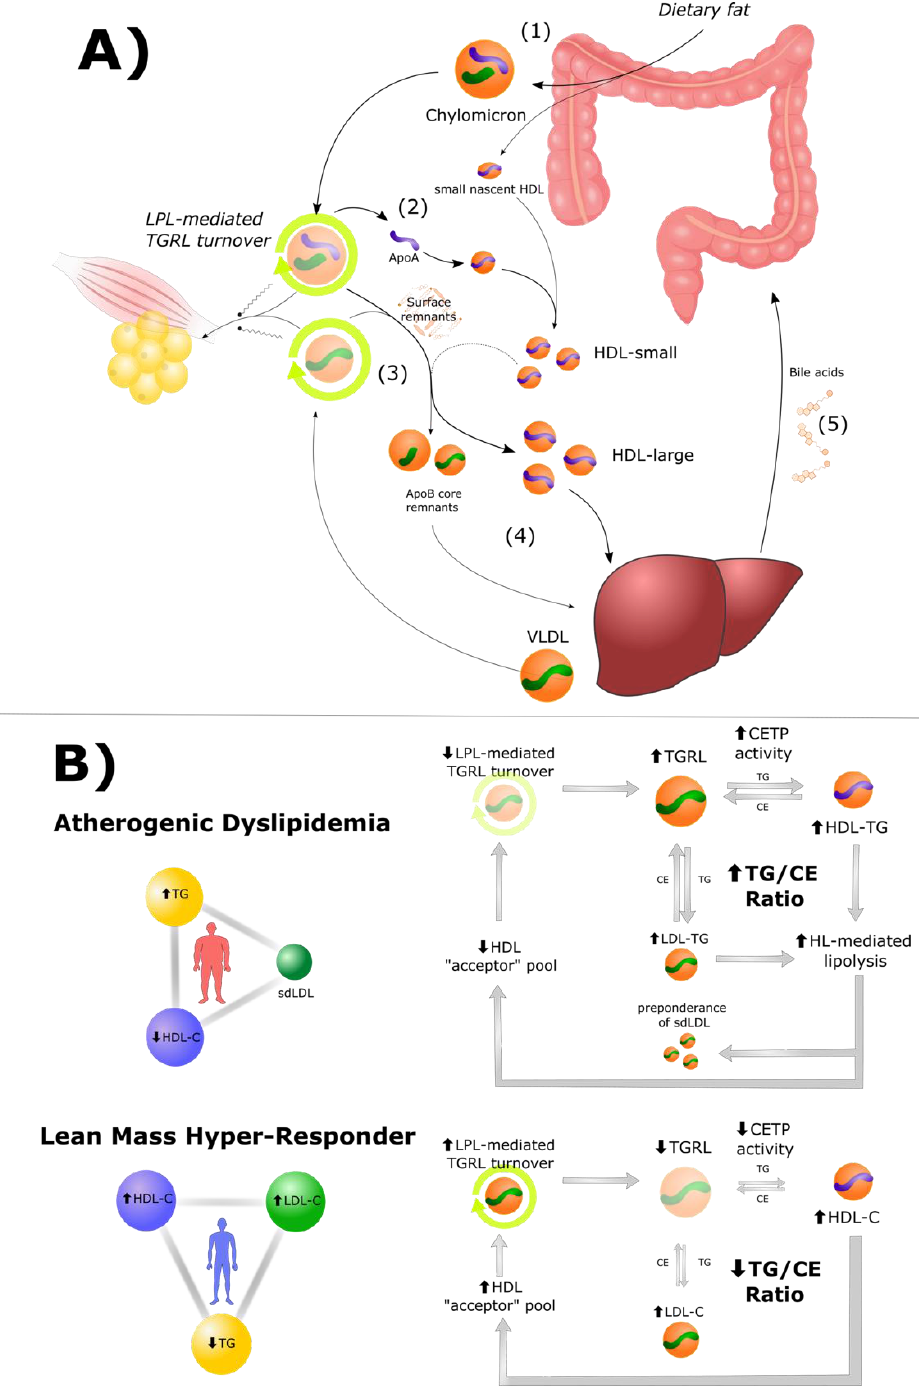
Figure 3. High HDL is a result and cause of efficient lipoprotein lipase-mediated triglyceride-rich lipoprotein metabolism, and vice versa . ( A ) (1) Ingestion of dietary fat contributes to production of small nascent HDL particles and apoA-I-containing chylomicrons. (2) Lipoprotein lipase (LPL)-mediated catabolism of chylomicrons yields lipid-free/lipid-poor apoA-I to further contribute to the pool of small HDL “acceptor” particles. (3) As LPL-mediated catabolism of triglyceride-rich lipoproteins (TGRLs, including chylomicrons and VLDLs) occurs, TGRLs release surface remnants. Surface remnants, bilayer structures including cholesterol, phospholipids, and apolipoproteins, are predominantly taken up by small acceptor HDL particles. (4) Through this process, lipoproteins, originating as TGRLs, remodel to intermediate-density lipoprotein (IDL) and finally to LDL and smaller chylomicrons and are returned to the liver. Large cholesterol-rich HDL (produced largely as a function of efficient LPL-mediated TGRL turnover) returns cholesterol to the liver, (5) to be